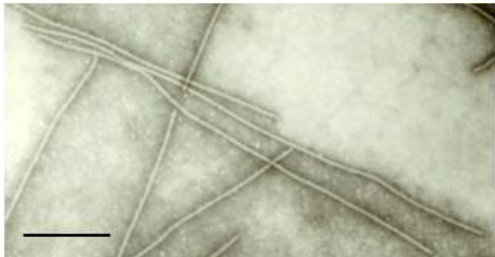
Figure 1. Transmission electron micrograph showing viral particles in sap of symptomatic V. unguiculata subsp. sesquipedalis leaf. Bar: 100